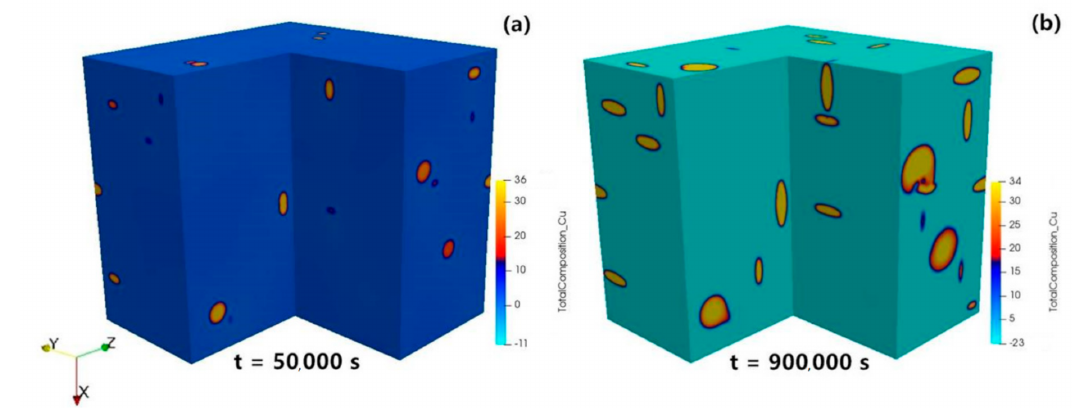
Figure 12. 3D large scale phase-field simulated concentration evolution of θ (cid:48) precipitation process in Al-1.69 at.% Cu alloy annealed at 453 K: ( a ) Aging time step = 50,000 s; ( b ) aging time step = 900,000 s.